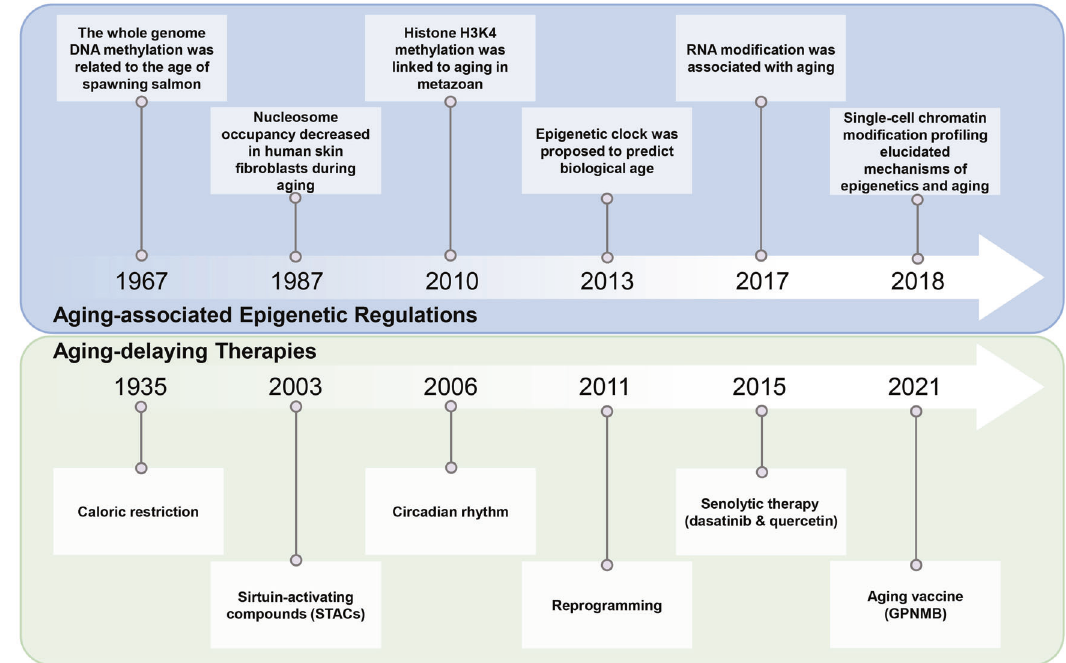
Fig. 1 The history of studies on aging-associated epigenetic regulation and